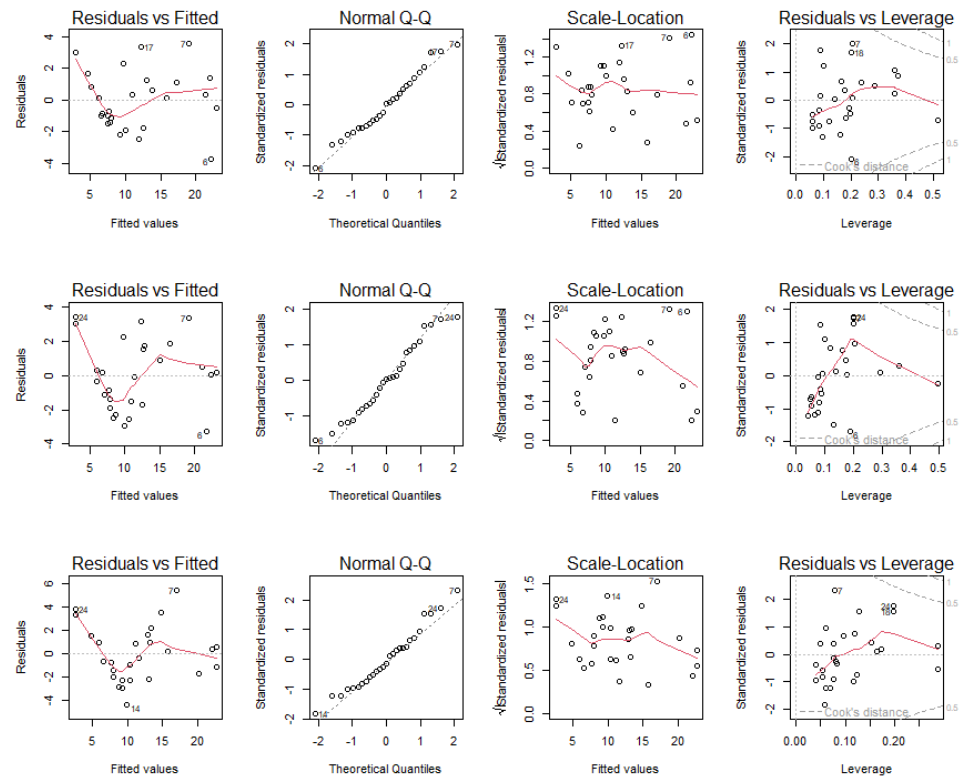
Figure A1. Goodness − of − fit of the chest press 1 − RM equation models.